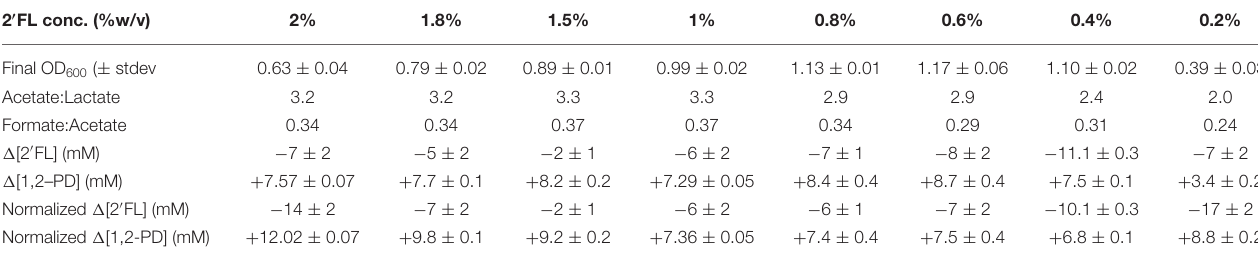
TABLE 3 | B. infantis 2 ′ fucosyllactose consumption and 1,2-propandiol production during growth on 2 ′ fucosyllactose as a sole carbohydrate source is not concentration-dependent when differences in final biomass are accounted for. However, acetate:lactate and formate:acetate ratios show some subtle variation with 2 ′ fucosyllactose